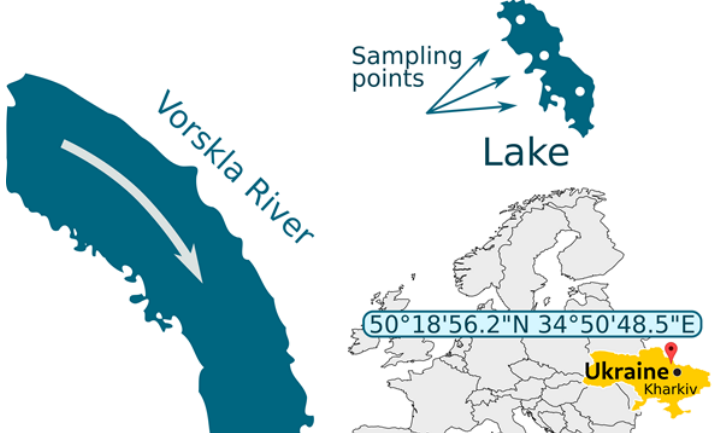
Figure 1. Map of geographical location and configuration of the lake. By origin, the lake is a fragment of the old Vorskla river bed. This fragment of the channel has existed as a lake for over 70 years. In the mid-20th century, this lake received wastewater, which significantly increased its trophic status. Currently, the lake receives